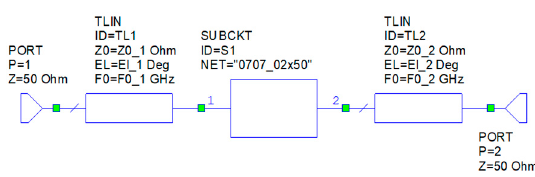
× 50 µ m sample device with two ideal transmission lines.